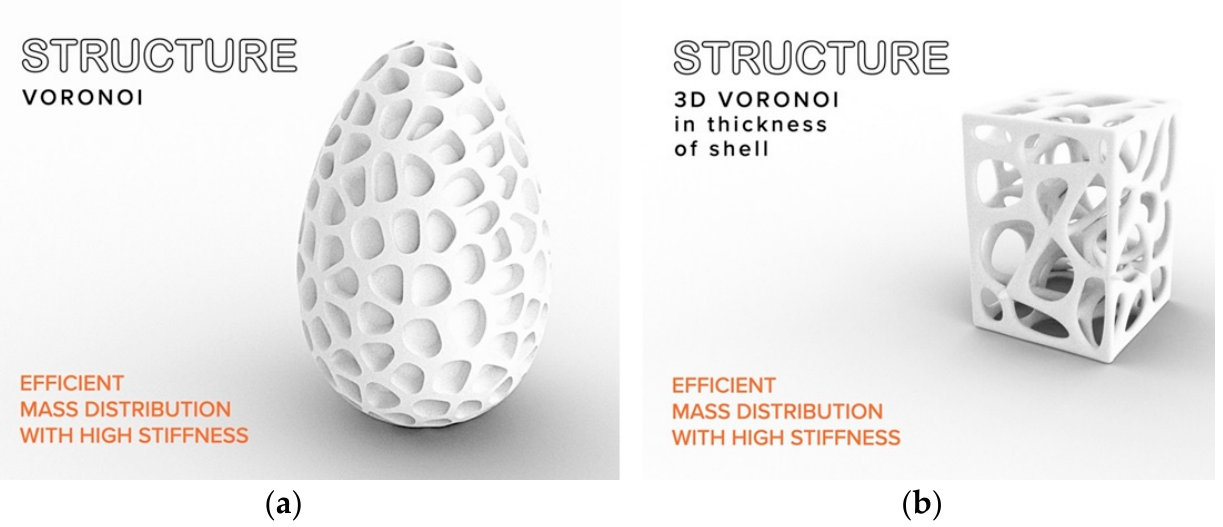
Figure 4. Generated model of the Voronoi structure: ( a ) implemented single-layer Voronoi structure on an egg-shaped surface, ( b ) cut-out of the 3D Voronoi structure that can be used for the entire outer wall thickness envelope.